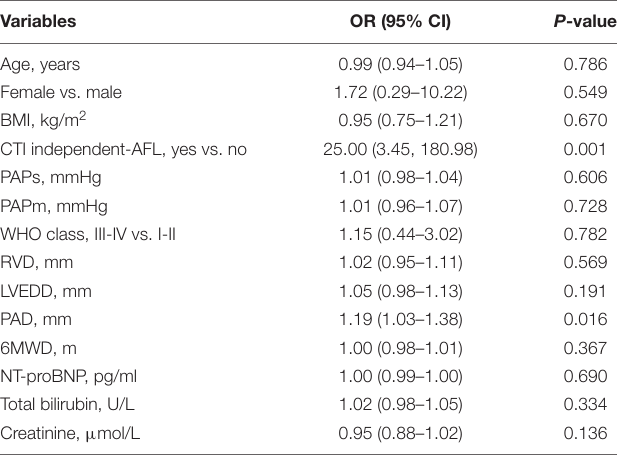
TABLE 3 | Univariate logistic analysis of predictors of failed